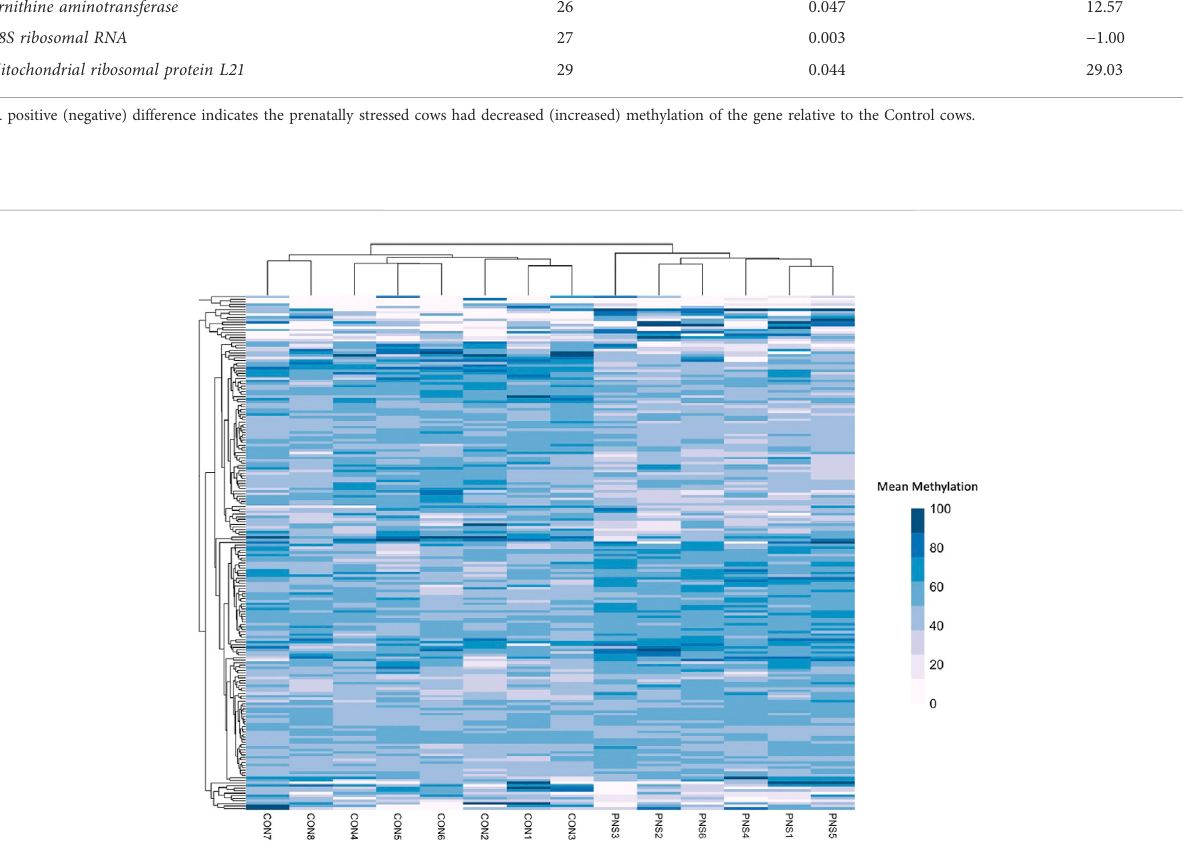
FIGURE 1 Heatmap showing the mean methylation of the differentially methylated ( n = 202) genes in the prenatally Stressed (PNS) cows and the Control